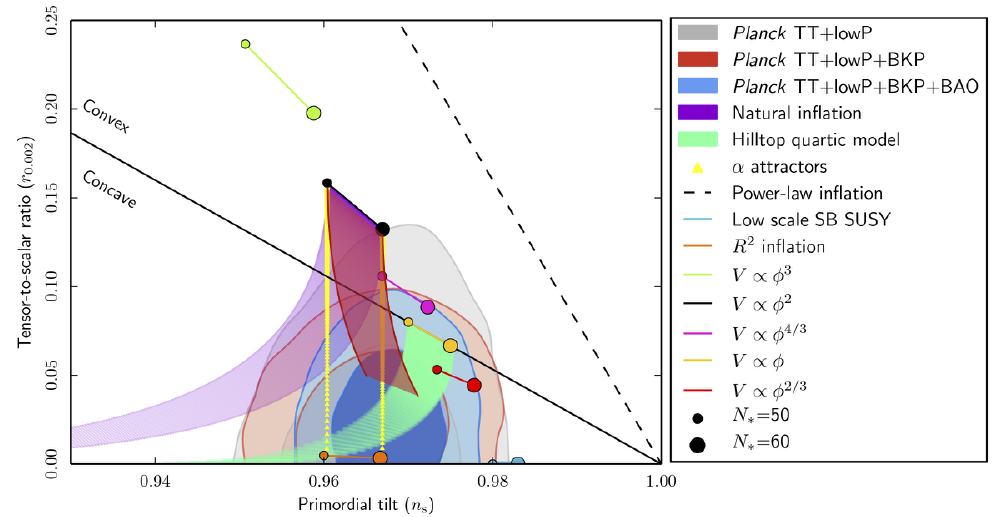
Figure 4 . Spectral index n s vs. tensor-to-scalar ratio r superimposed over the plot given by the Planck collaboration [45] for the single (cid:12)eld model with 10 (cid:0) 4 6 ^(cid:7) 6 10 (cid:0) 2